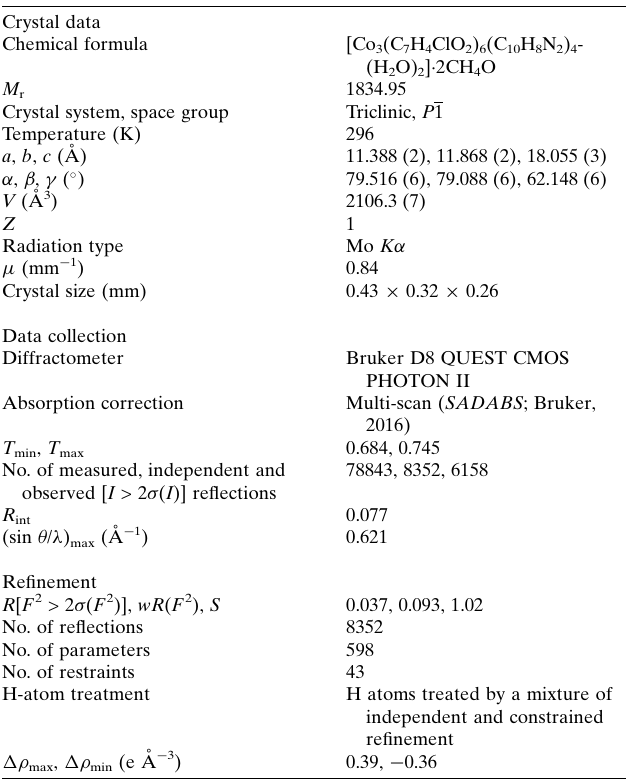
Crystal data Chemical